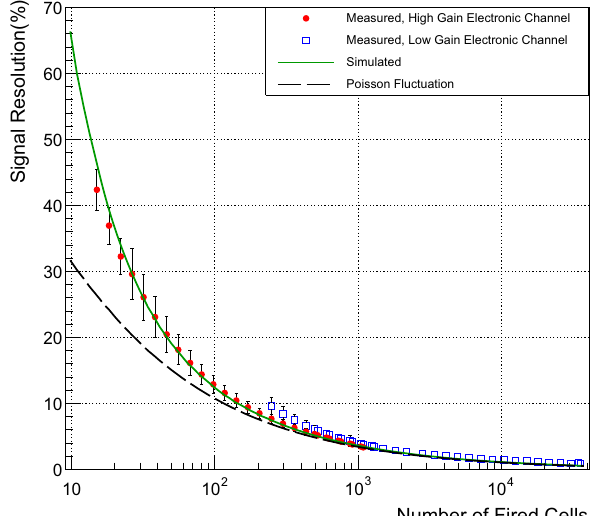
Fig. 15 The funnel adhesion jig. The adhesive used is LOCTITE (cid:2) EA Fig. 14 Signalresolutions( SR )of16,384pixelsofthefirst16WFCTA cameras. The red circles are the average SR of the high gain channels, andthebluehollowsquaresaretheaverage SR ofthelowgainchannels. The error bar represents the standard deviation of SR distribution of the pixels. The green line is the simulated SR . The black dashed line is the (cid:8) N pe Poisson fluctuation calculated from 1 /